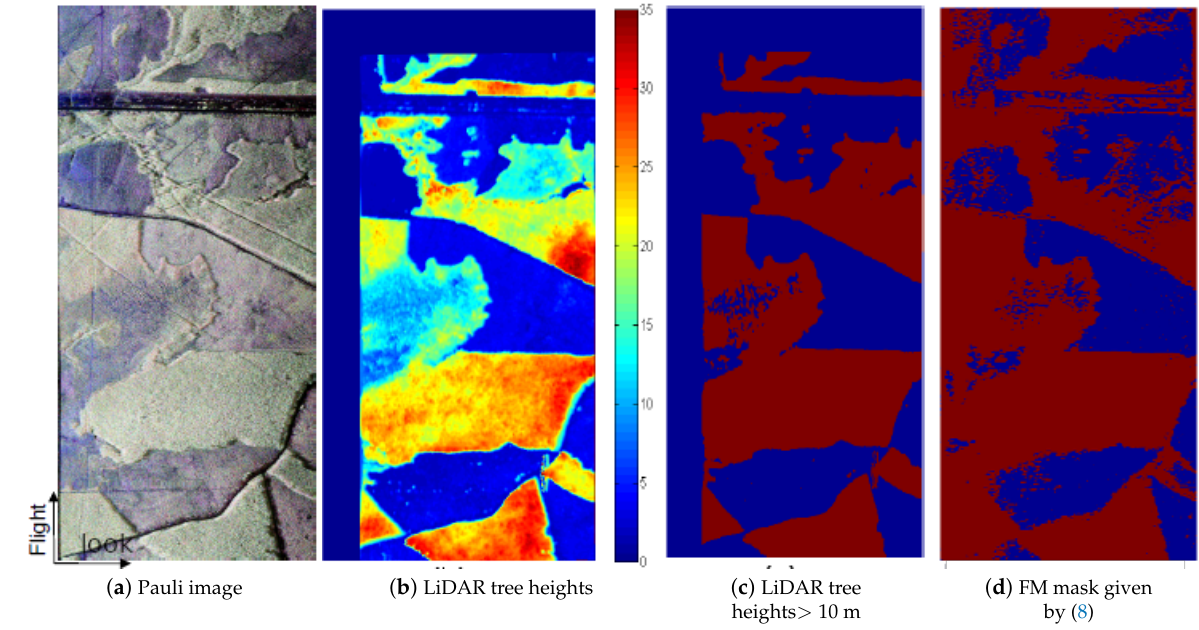
Figure 15. Generated forest/non-forest